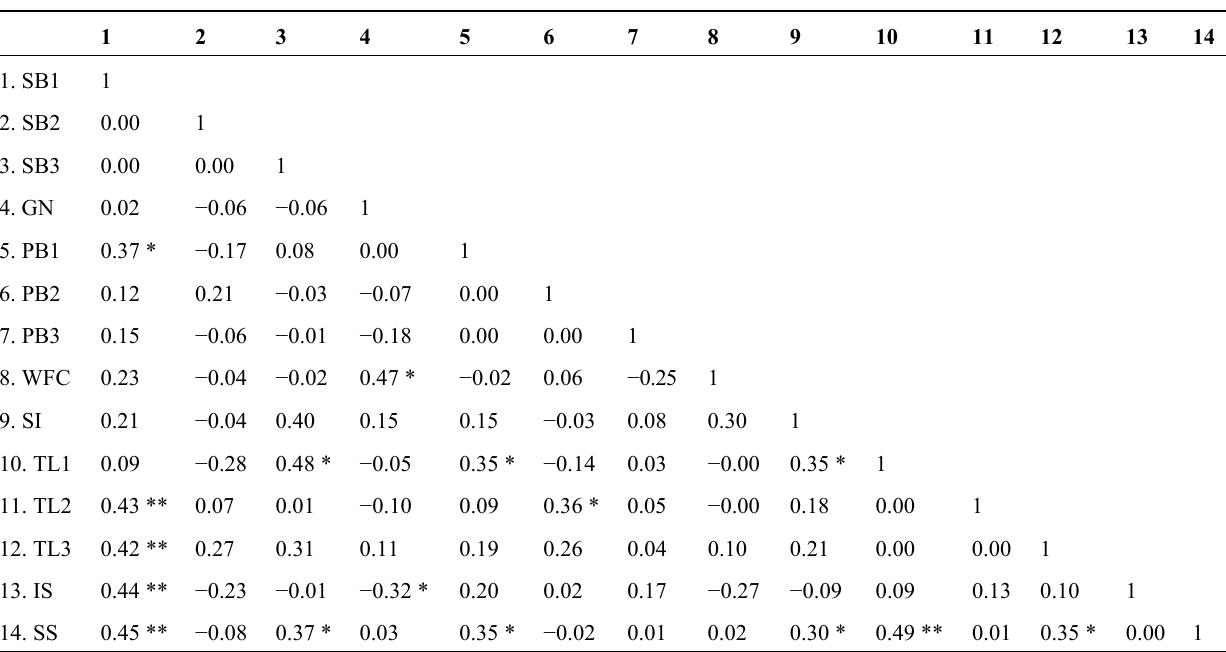
Table 2. Bivariate